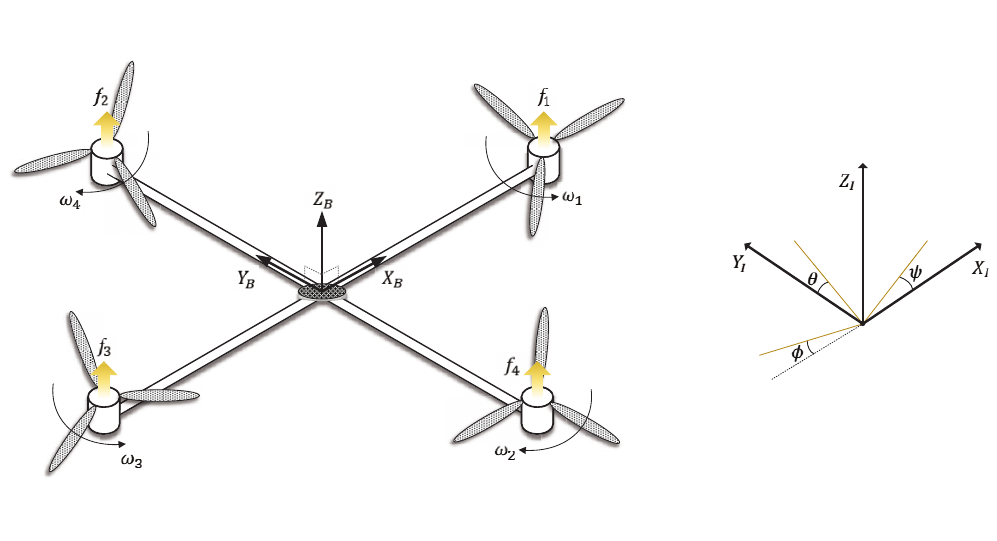
Figure 1. A schematic diagram of quadrotor system in the inertia ( • I ) and body ( • B )